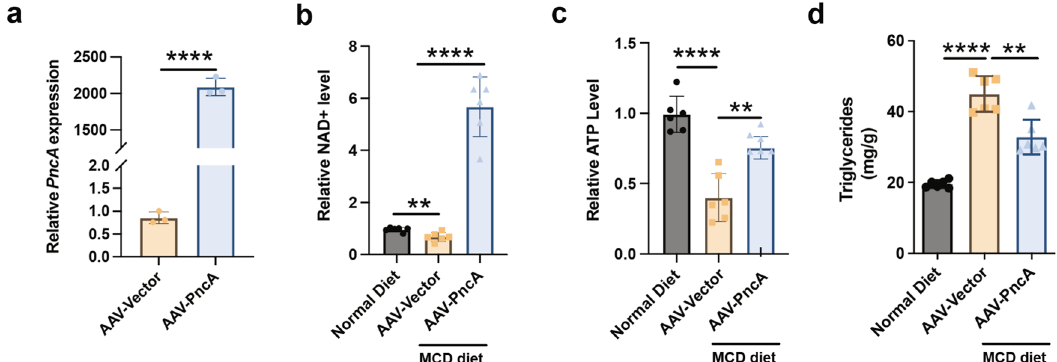
Fig. 5 Improvement of NAD + in mouse liver by PncA overexpression via liver-speci fi c AAV. a PncA expression in mouse liver in the control and PncA groups ( n = 3, **** p < 0.0001). b Relative content of NAD + in mouse liver. c Relative content of ATP in mouse liver. d Content of triglyceride in mouse liver. ( n = 6, ** p < 0.01, **** p <